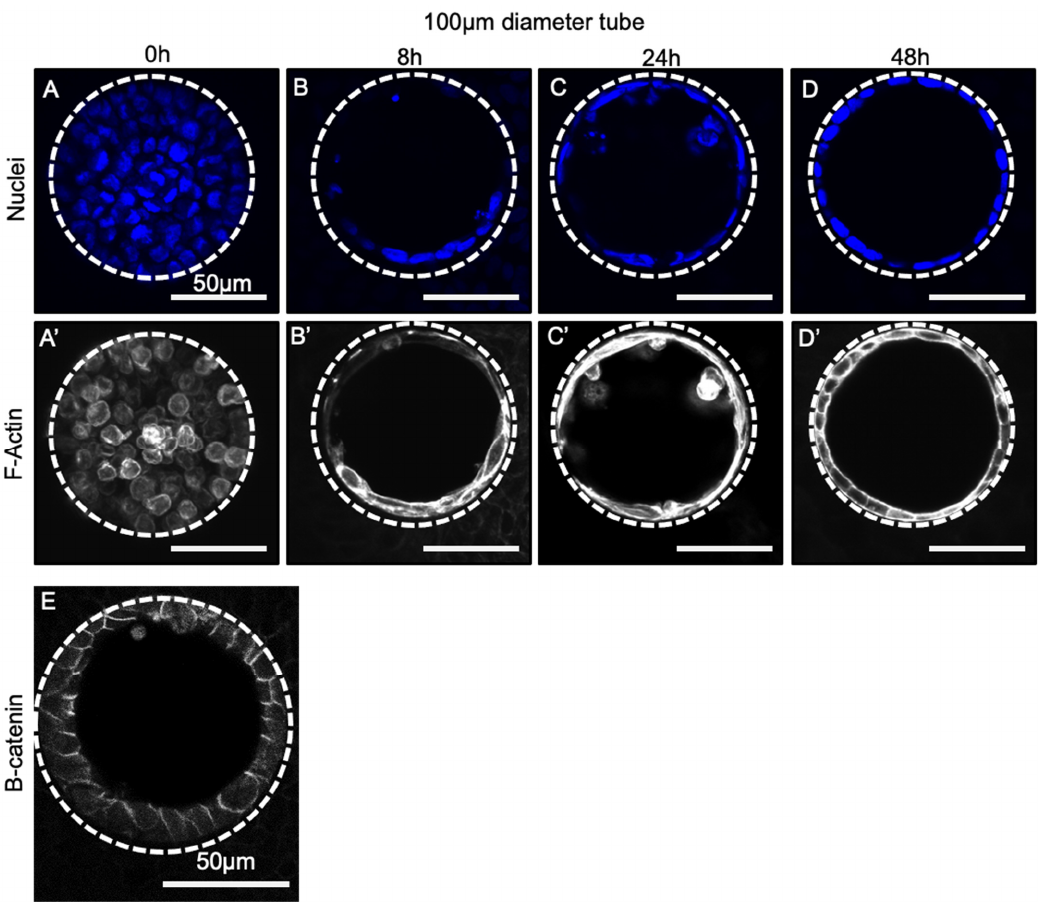
Figure 4. Tube formation dynamics over 48 h in 100 µm tubes. Fluorescent micrographs of 100 µm tubes seeded with day 17 lung progenitors and stained with DAPI (blue) at 0 h ( A ), 8 h ( B ), 24 h ( C ), and 48 h ( D ) showing partial tube formation by 8 h and complete formation occurring within 48 h. Corresponding F-actin staining (white) in ( A’ – D’ ) reveals a similar pattern. ( E ) Beta-catenin staining (white) was also assessed to characterize cell polarization within 100 µm tubular constructs. Bar, 50 µm; the dotted white line approximates the PDMS border; n = 3.